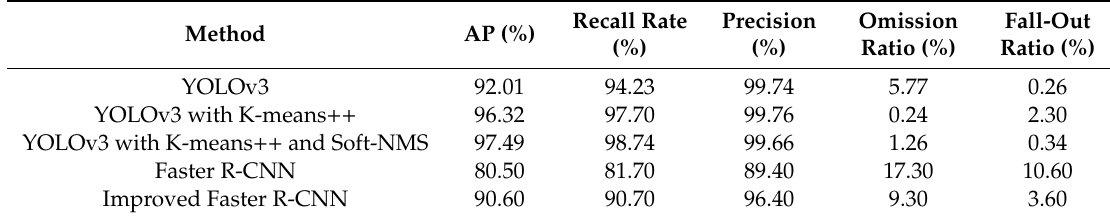
Table 6. Comparison of the test